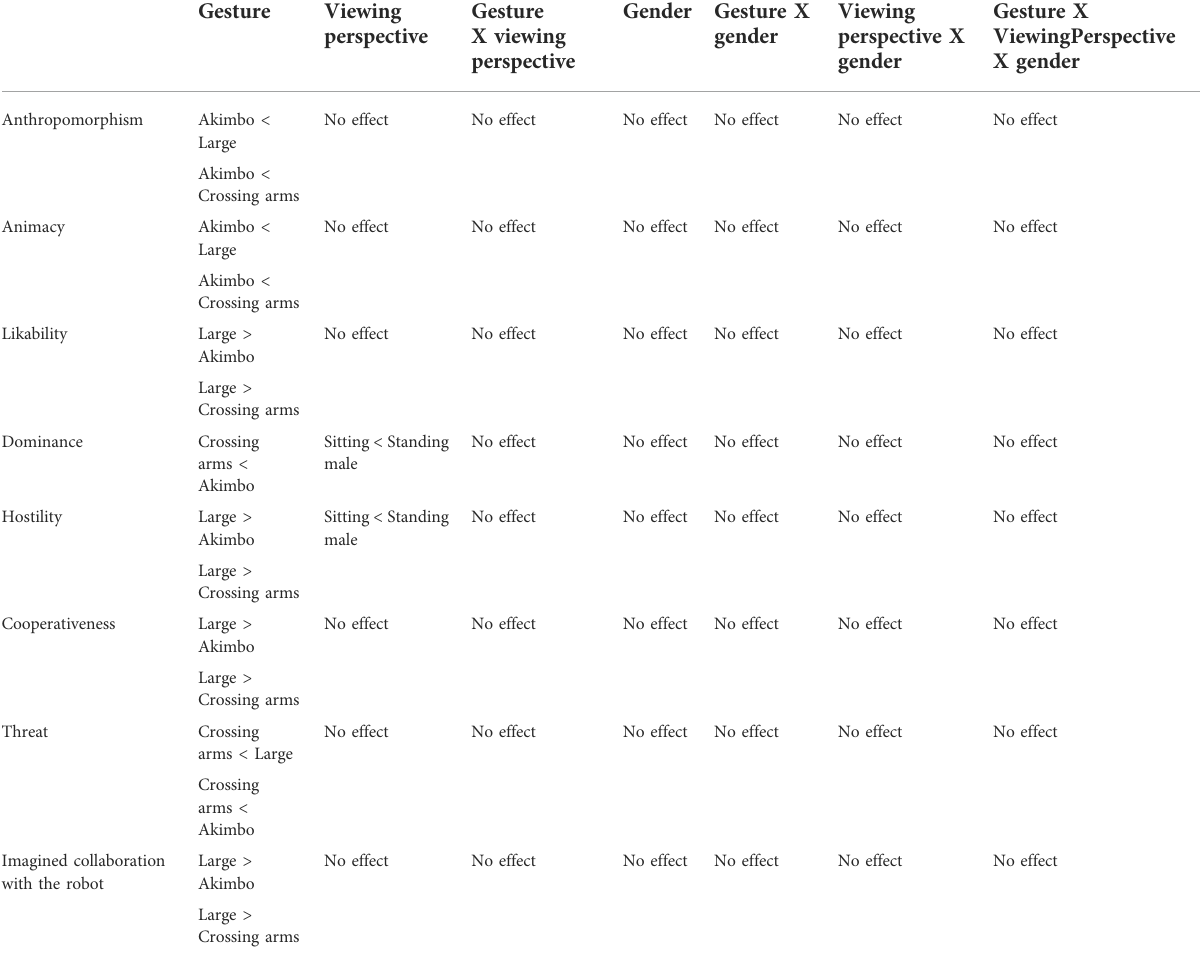
TABLE 10 Overview of the signi fi cant differences for all dependent variables. High values indicate a high degree of the respective attribute